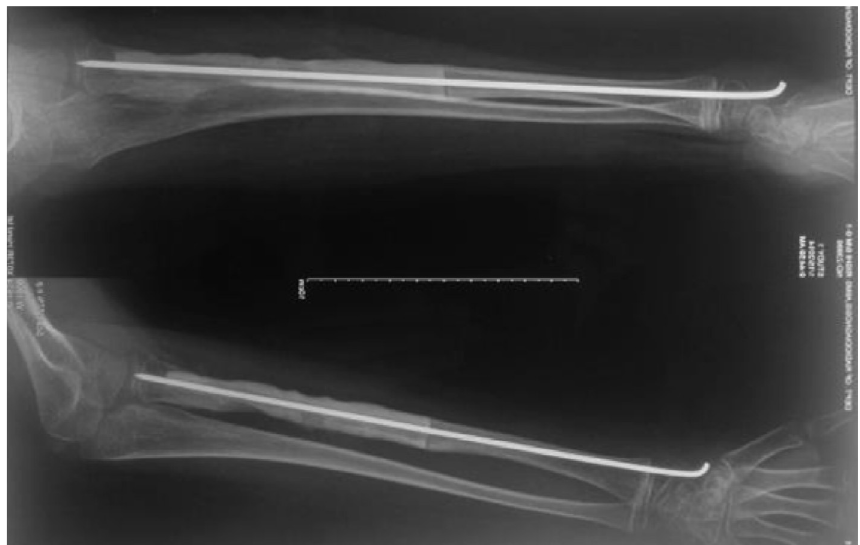
Figure 7. Twelve weeks follow-up X-ray showing incorporation of the graft at the parent-allograft bone interface; resorption of cortical margins is visible. 35 mg of alendronate was started at this